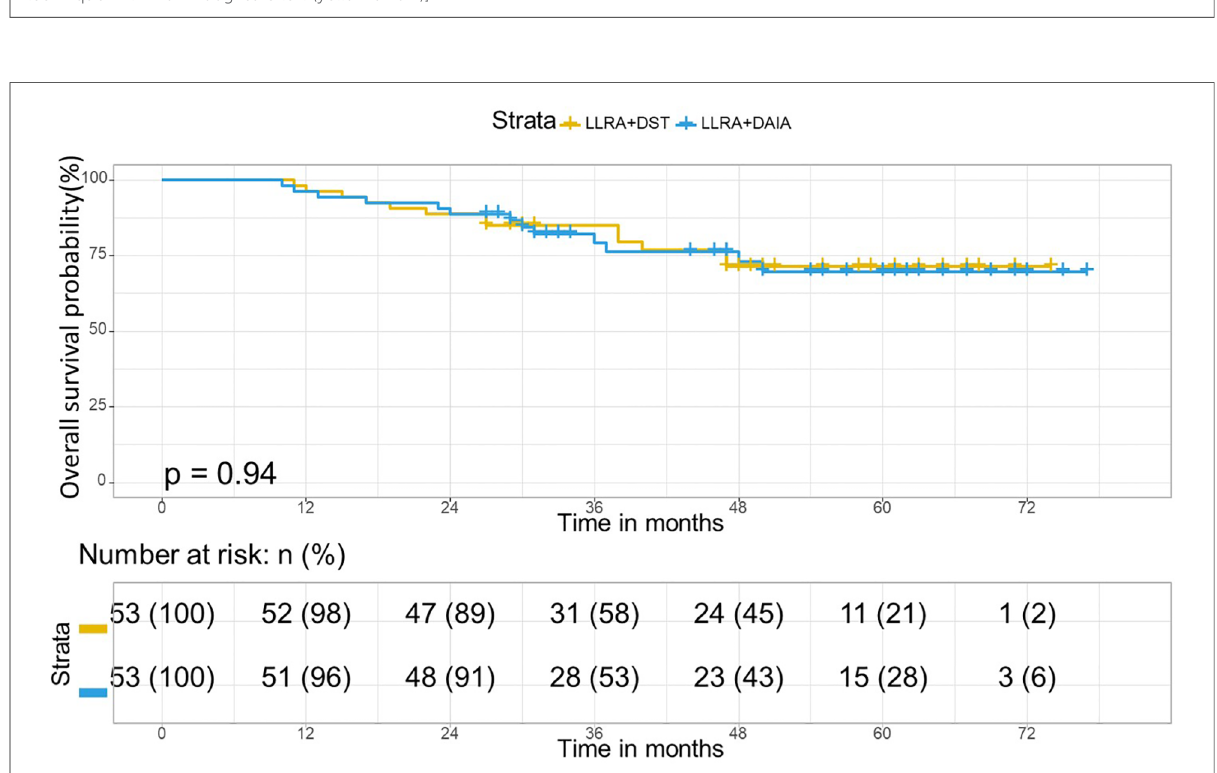
FIGURE 3 Endoscopic evaluation of anastomosis at 6-month follow-up [ A, C : “ dog-ear ” invagination anastomosis had no “ dog-ears ” left, B, D : double-staple technique with 1 or 2 dog-ears left (yellow arrow)].